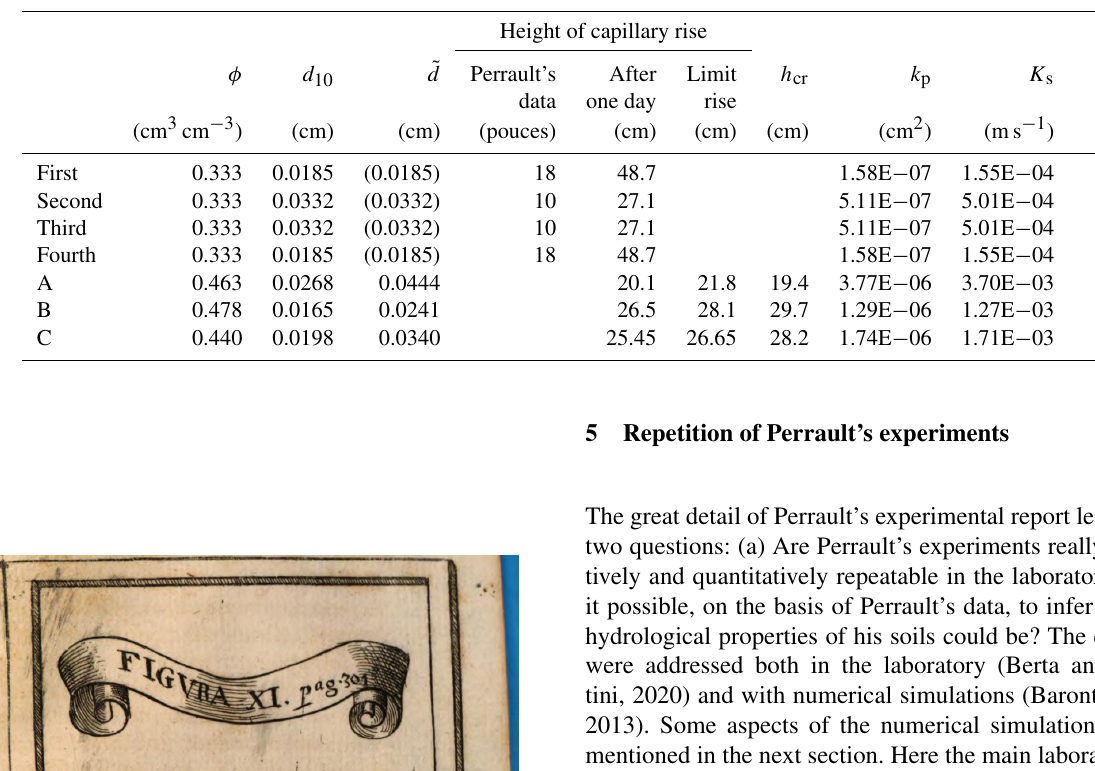
Table 4. Height of capillary rise and characterization of Perrault’s soils (first, second, third, fourth) and of the soils used for the repetitions of the first experiment (A, B, C). φ : porosity; d 10 : characteristic diameter for the Polubarinova-Kochina’s relationship; ˜ d : characteristic diameter for Kozeny and Carman’s relationship; h cr : Polubarinova-Kochina’s capillary rise; k p : Kozeny and Carman’s intrinsic permeability; K s : Kozeny and Carman’s hydraulic conductivity at saturation. Perrault’s soils are described in Table 3.